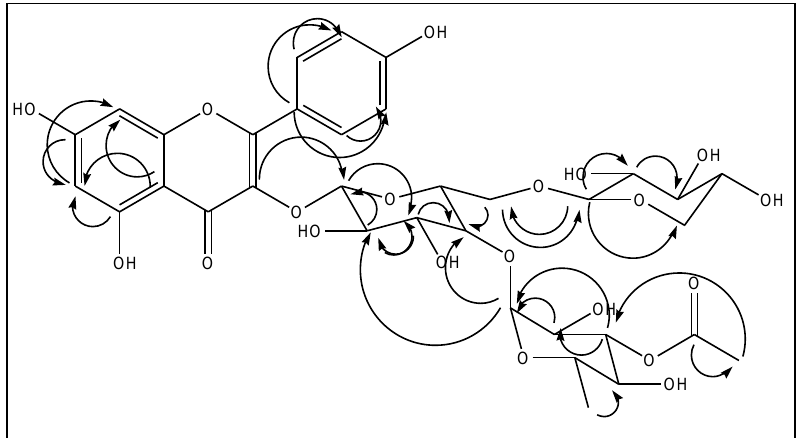
Figure 4. Selected HMBC correlations for compound 1 .